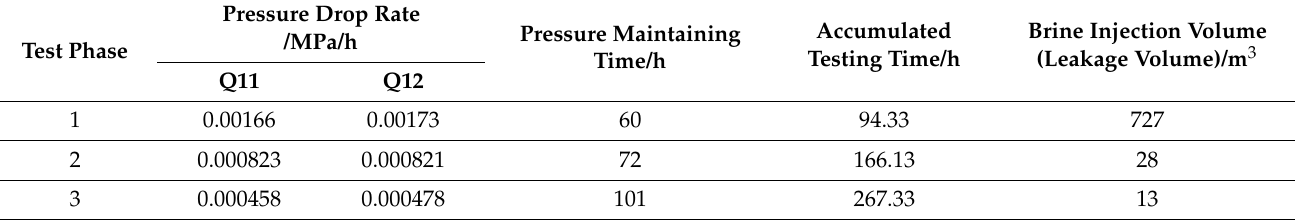
Table 1. Brine Injection Test data.